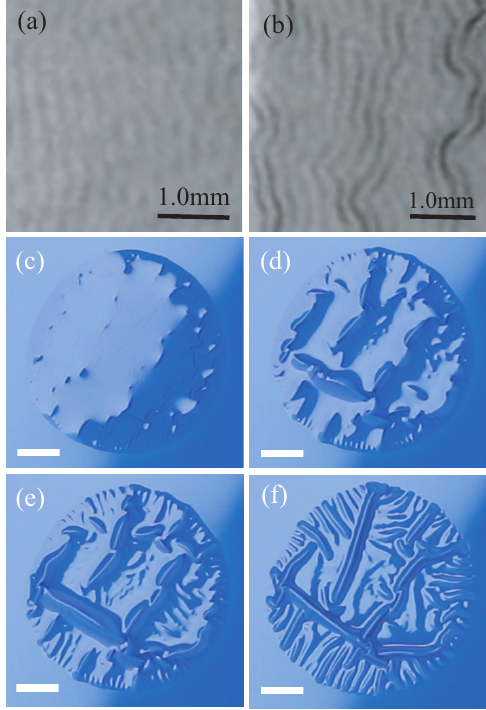
Figure 1. Deformations of the paint layer at ( a ) t = 58 s, ( b ) 63 s, ( c ) 90 s, ( d ) 120 s, ( e ) 150 s, and ( f ) 300 s, where t = 0 is the time when the organic solvent is applied to the layer. The contrast of ( a , b ) is modified only for clearer demonstration of wrinkles. These photographs all apply to experiments for which the curing time T = 24 h. The solid lines in panels ( a , b ) are 1.0-mm-scale bars, and those in panels ( c – f ) are 3.0-mm-scale bars.